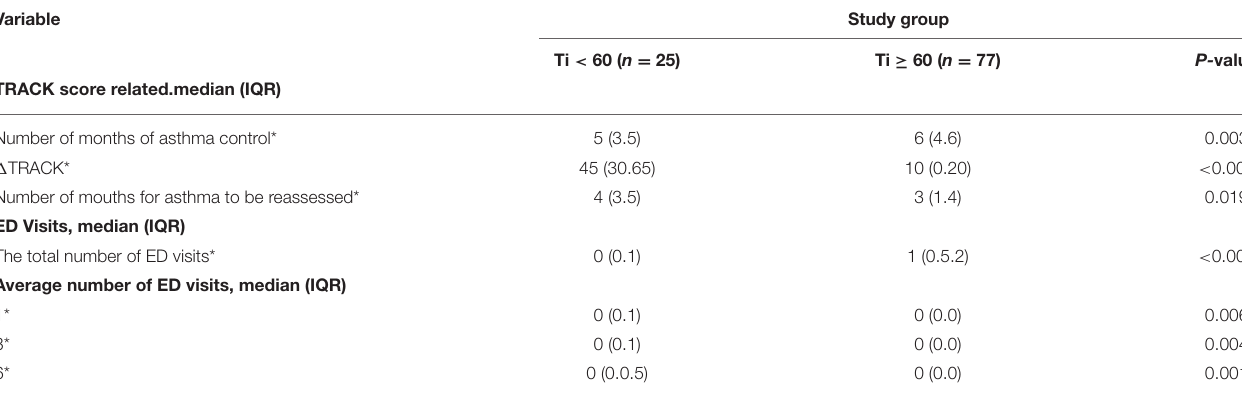
TABLE 3 | Characteristics of pre-schoolers with asthma at 6-mouth follow-up visit.